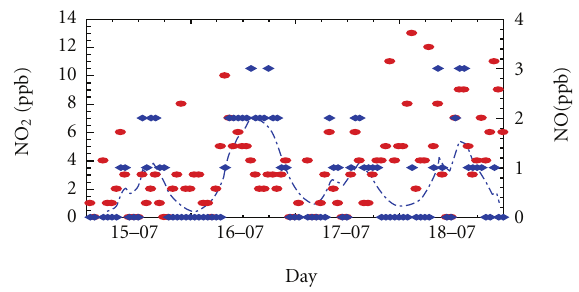
Figure 11: Hourly averaged series of pollutants concentrations during a summer period in Sousse city. Time evolution of the Left y axis is plotted with solid line, and the right one is plotted with dashed